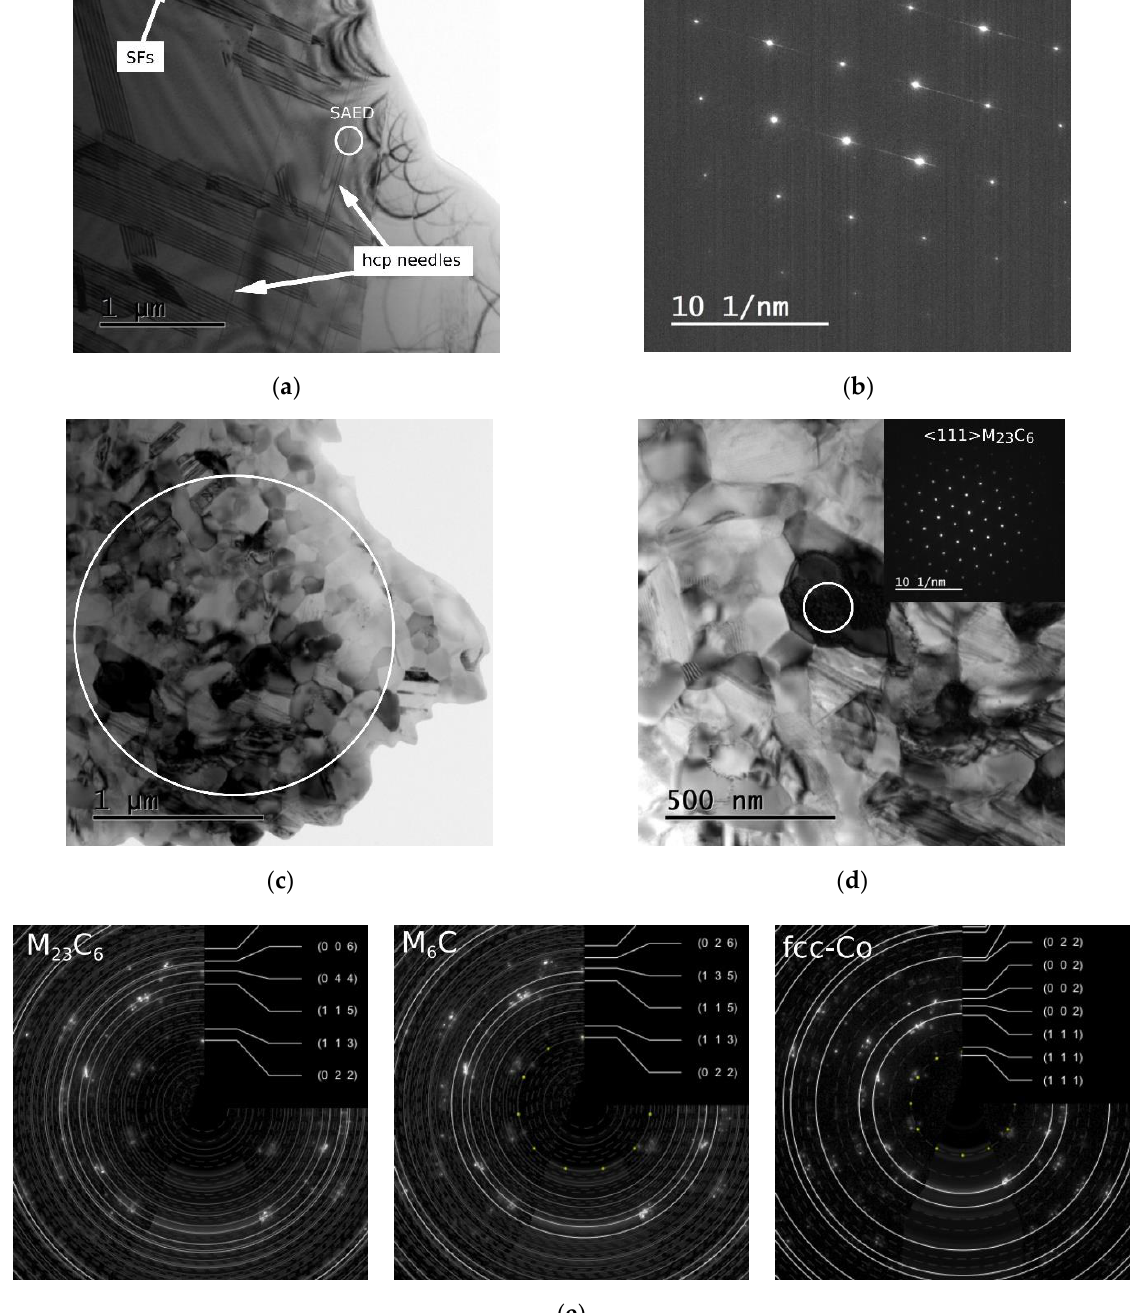
Figure 5. TEM observations of the initial microstructure of the cast Co-Cr-Mo alloy: ( a ) fcc matrix with hcp needles; ( b ) diffraction pattern for image ( a ); ( c ) domain of carbidic precipitates; ( d ) M 23 C 6 carbide; ( e ) Laue diffraction patterns for image ( c ). Table 3. Point TEM-EDS analyses in selected areas of the carbidic domain (wt%). Scanning Transmission Electron Microscopy (STEM)-High-An- gle Annular Dark-Field (HAADF) Image with Selected Points